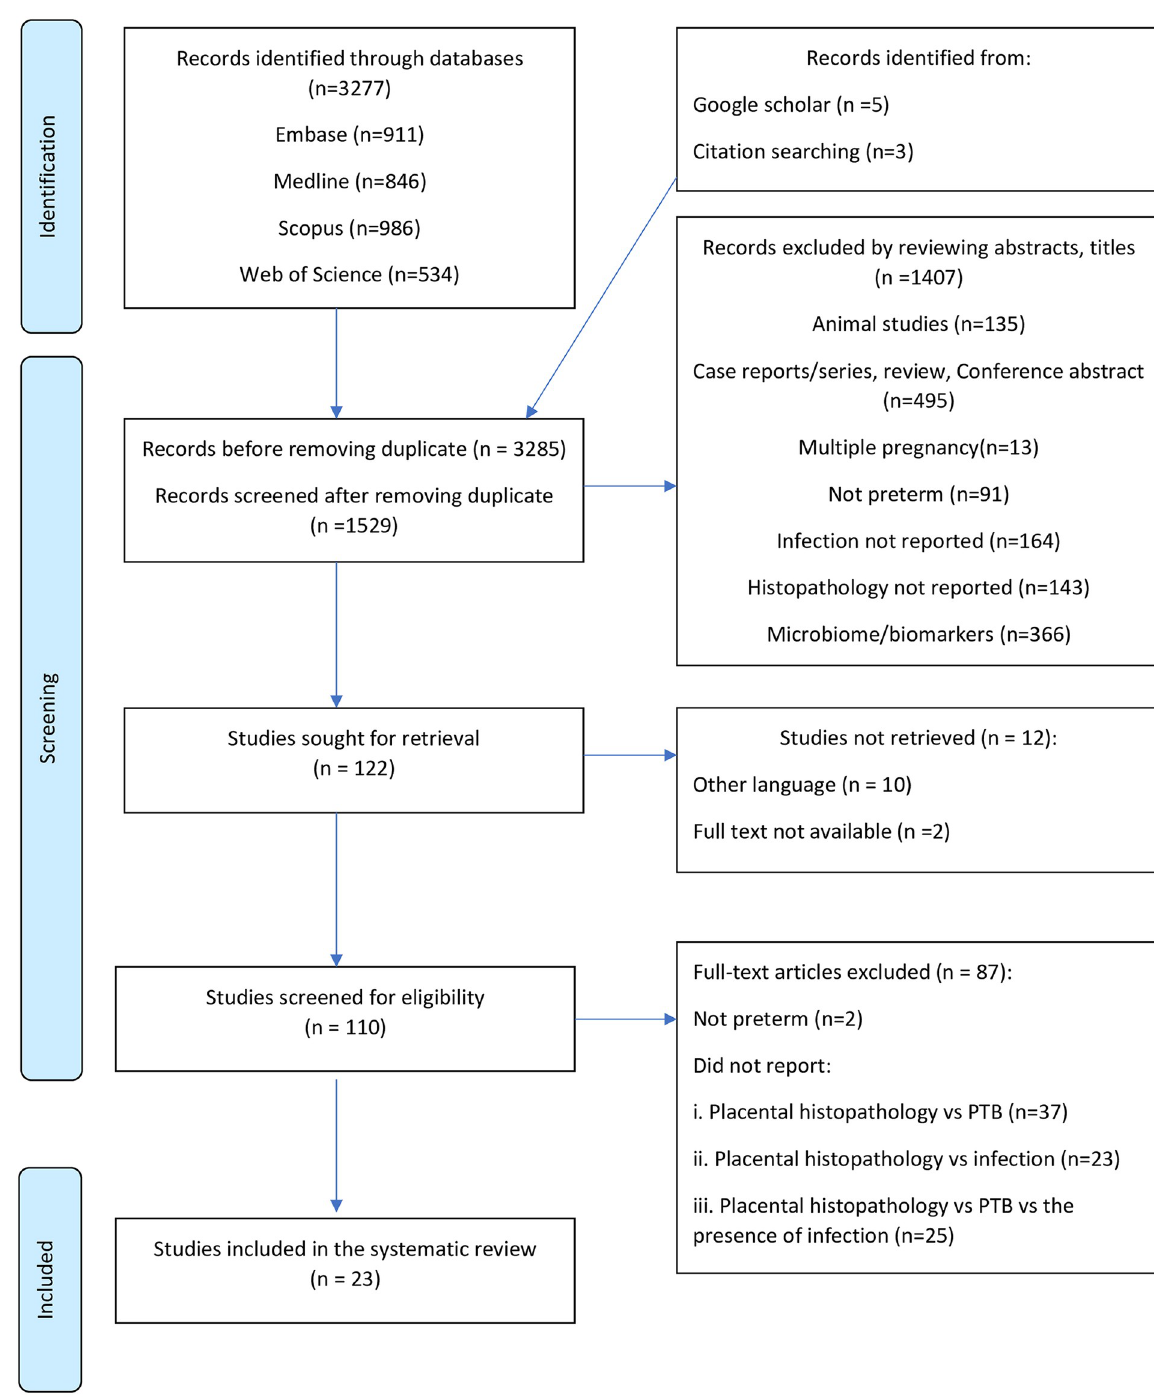
Fig 1. Prisma flow